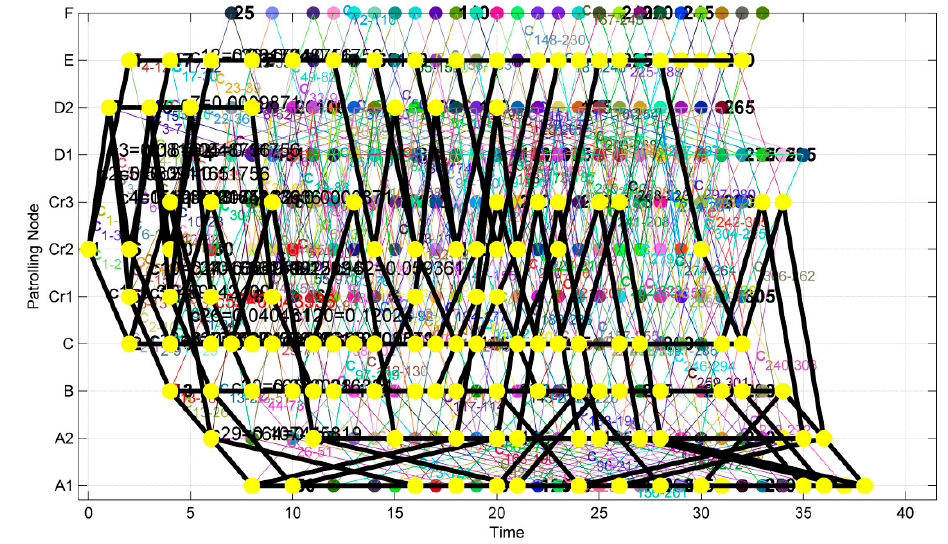
Figure 4. Optimal patrolling strategy generated by CCEPP game for a patrol team.